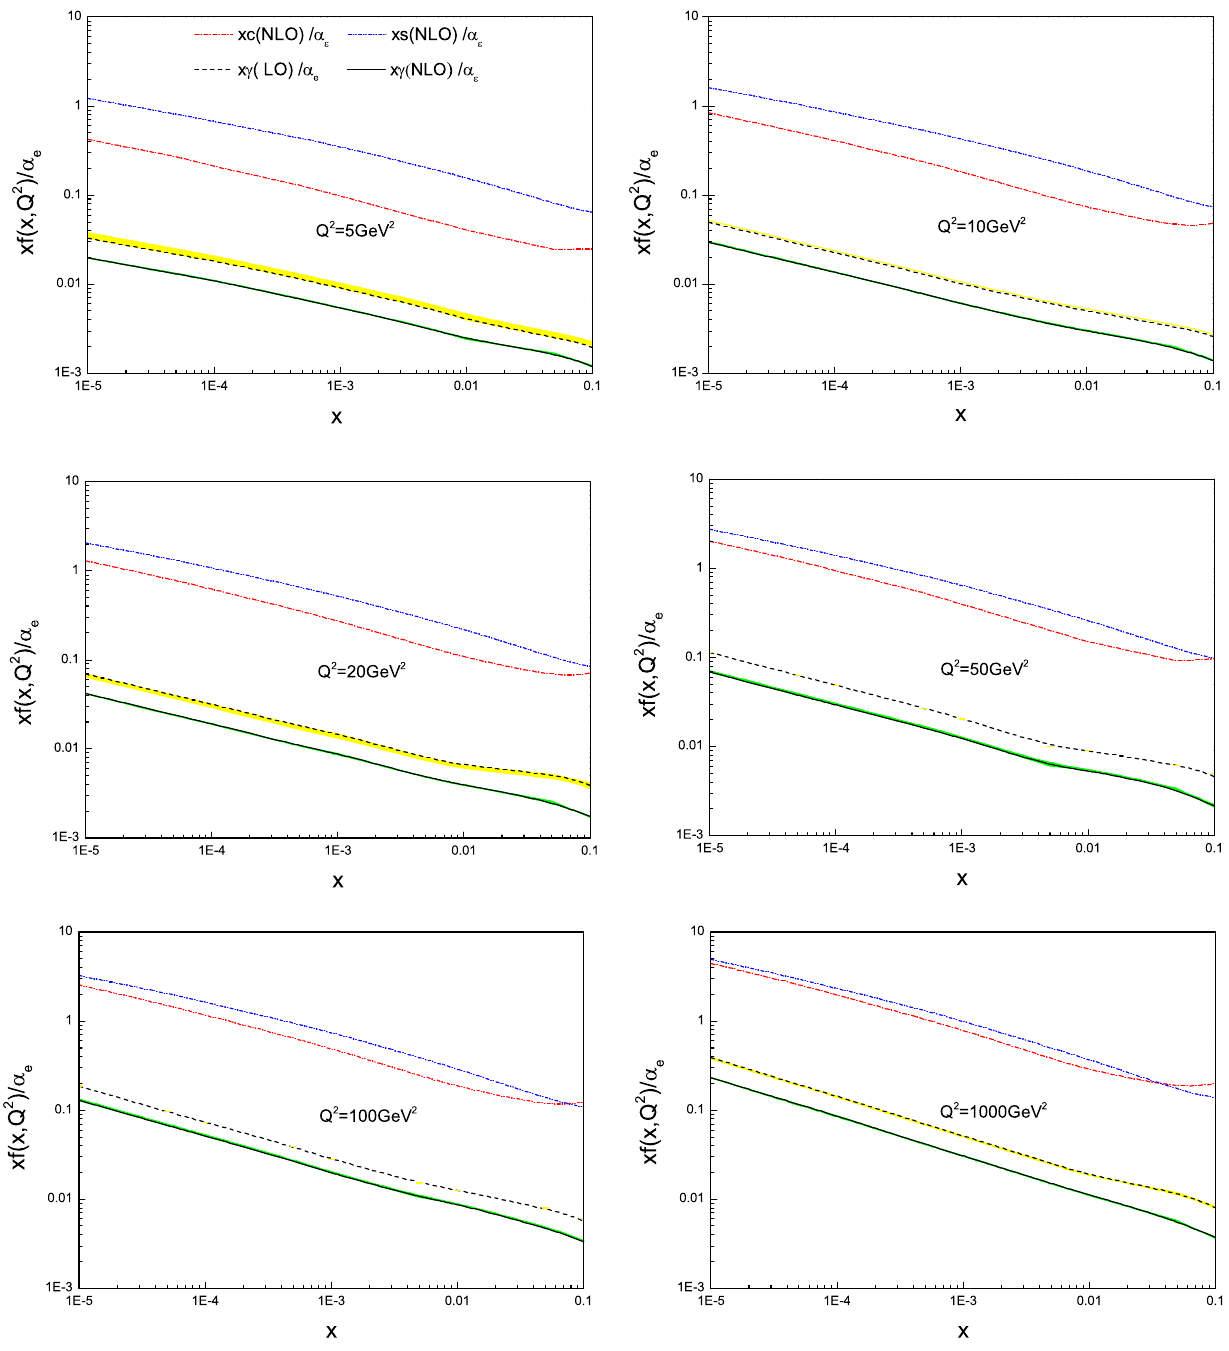
Fig. 9 The photon distribution function at scales Q 2 = 5 , 10 , 20 , 50, 100, and 1000 GeV 2 in LO and NLO in comparison with the c -quark and s -quark distribution functions of the photon at NLO provided by the GRV results except for the experimental data released by the ALEPH col- laboration.Asillustrated,ouranalyticalsolutionsforthepho- ton structure function over a wide range of x and Q 2 values are in good agreement, especially at LO, with the experi- mental data provided by L3, OPAL, DELPHI, and PLUTO